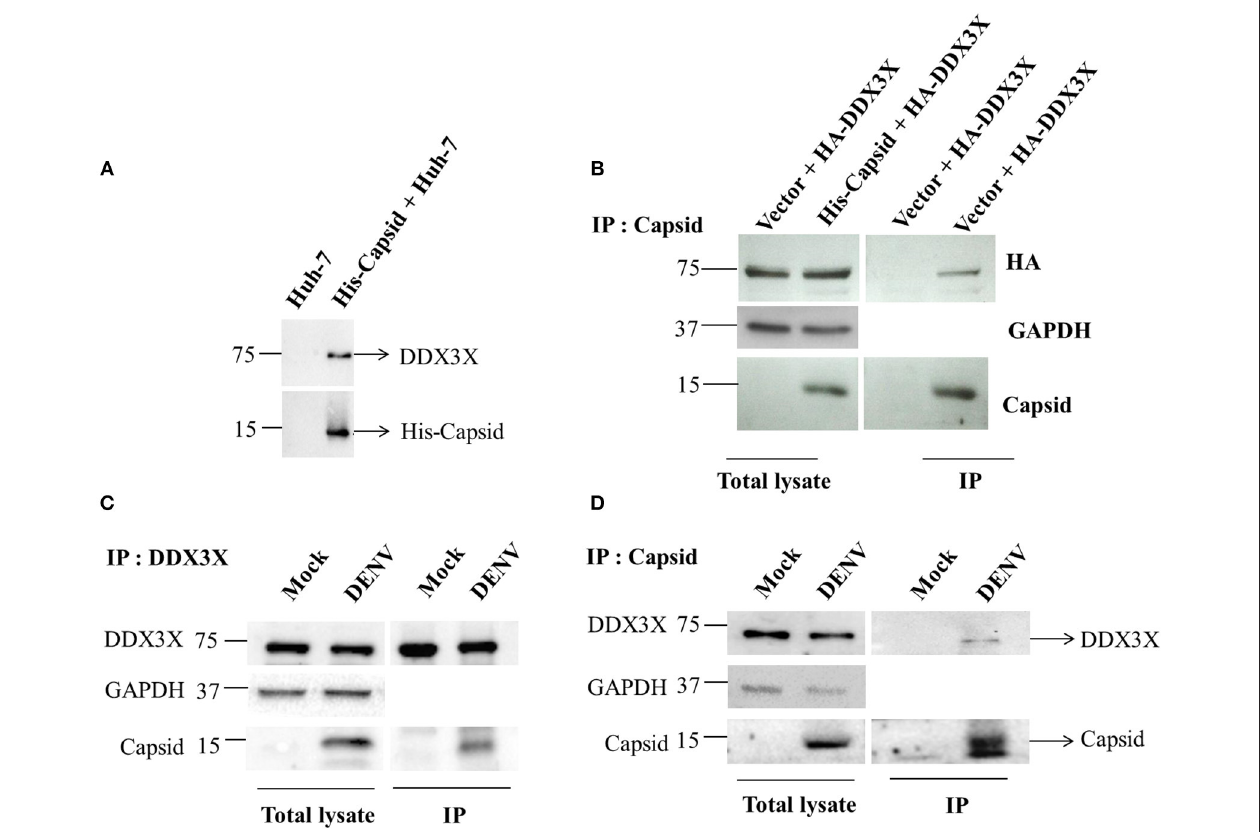
FIGURE 1 | Capsid coimmunoprecipitates with DDX3X from cell lysates. (A) In-solution interaction of purified His-tagged DENV capsid and Huh-7 lysate was followed by pull-down of interacting proteins using Ni-NTA beads. Pull down with Huh-7 lysate alone is used as a control. (B) His-tagged DENV capsid and HA-DDX3X were co-transfected in HEK293T cells. 24h p.t. lysate was prepared and capsid was immunoprecipitated using DENV capsid antibody. Total lysate and immunoprecipitated proteins were analyzed by western blots probed for capsid, HA and GAPDH. (C,D) Huh-7 cells were infected with DENV at an MOI of 5. At 24h pi mock and DENV-infected Huh-7 cell lysates were prepared, endogenous DDX3X (C) or DENV capsid (D) was immunoprecipitated from total lysates using DDX3X or DENV capsid antibody respectively. Total lysate and immunoprecipitated proteins were analyzed by western blots probed for capsid and